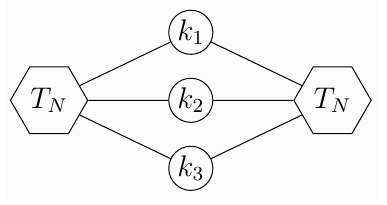
Figure 2 . Two T N theories gauged with SU( N ) k